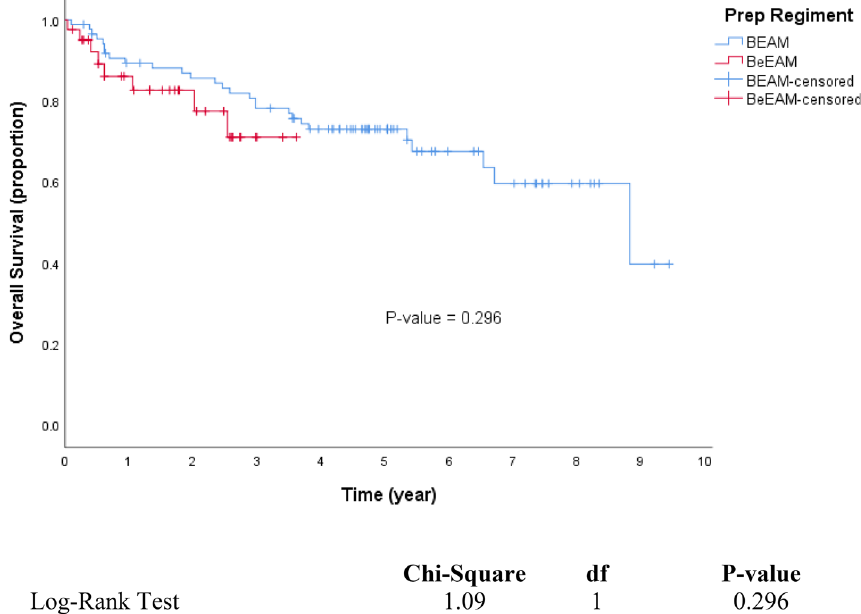
Figure 1. Kaplan–Meier analysis of overall survival. Overall survival (OS) in patients who underwent an ASCT with BEAM or BeEAM. ASCT autologous stem cell transplantation, BEAM BCNU, etoposide, cytarabine, melphalan, BeEAM bendamustine, etoposide, cytarabine, melphalan. p values were determined using the log- rank test.